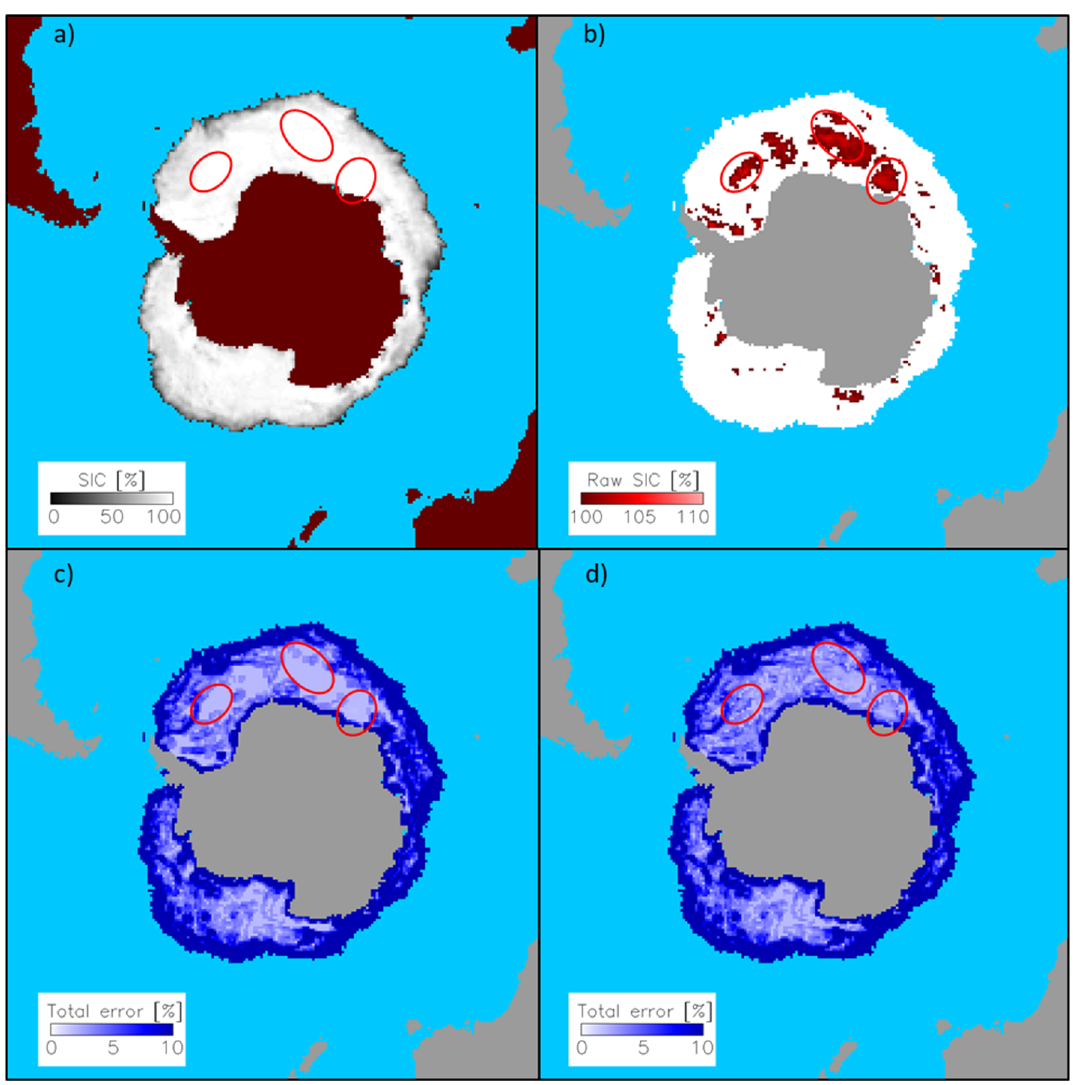
Figure 2. Maps of truncated SIC ( a ), non-truncated (=Raw) SIC focusing on values >100% ( b ), the original total error ( c ) and the corrected (see text) total error ( d ) of 9 October 2010, in the Southern Hemisphere. Shown are SICCI-50km data. I optimized the range of total error values shown to better illustrate error variations in high-concentration areas; maximum values actually peak at ~40%. Red ellipses highlight two regions with a pronounced fraction of SIC > 100%, indicating in maps ( c , d ) how the total error changes in response to the correction carried out.